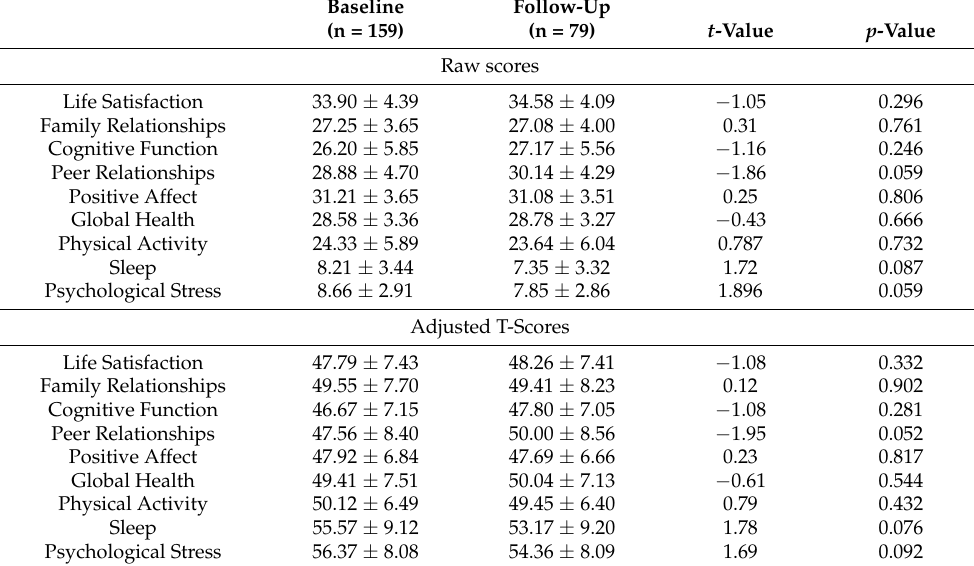
Table 2. NIH PROMIS